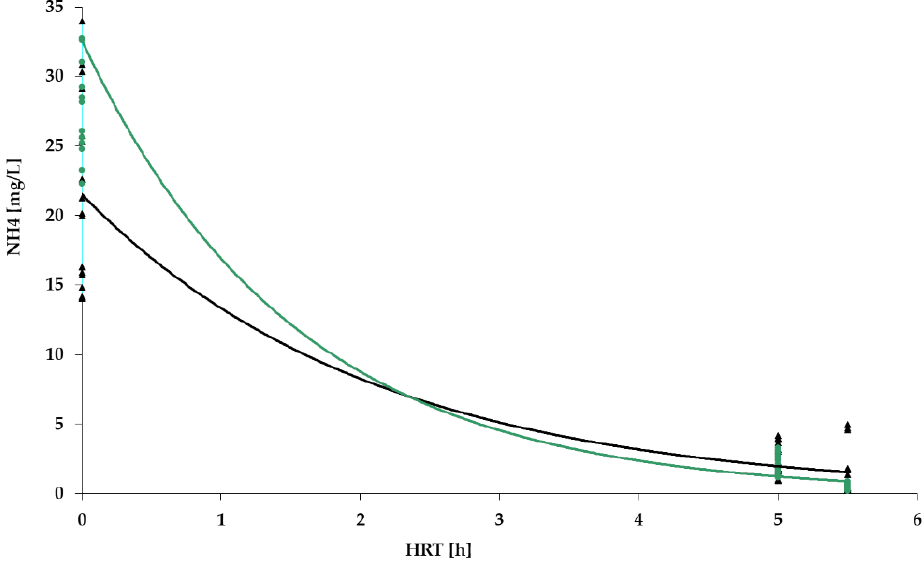
Figure 15. NH 4 removal dynamics for PV floating carrier: stage 1 (black); stage 2 (green).